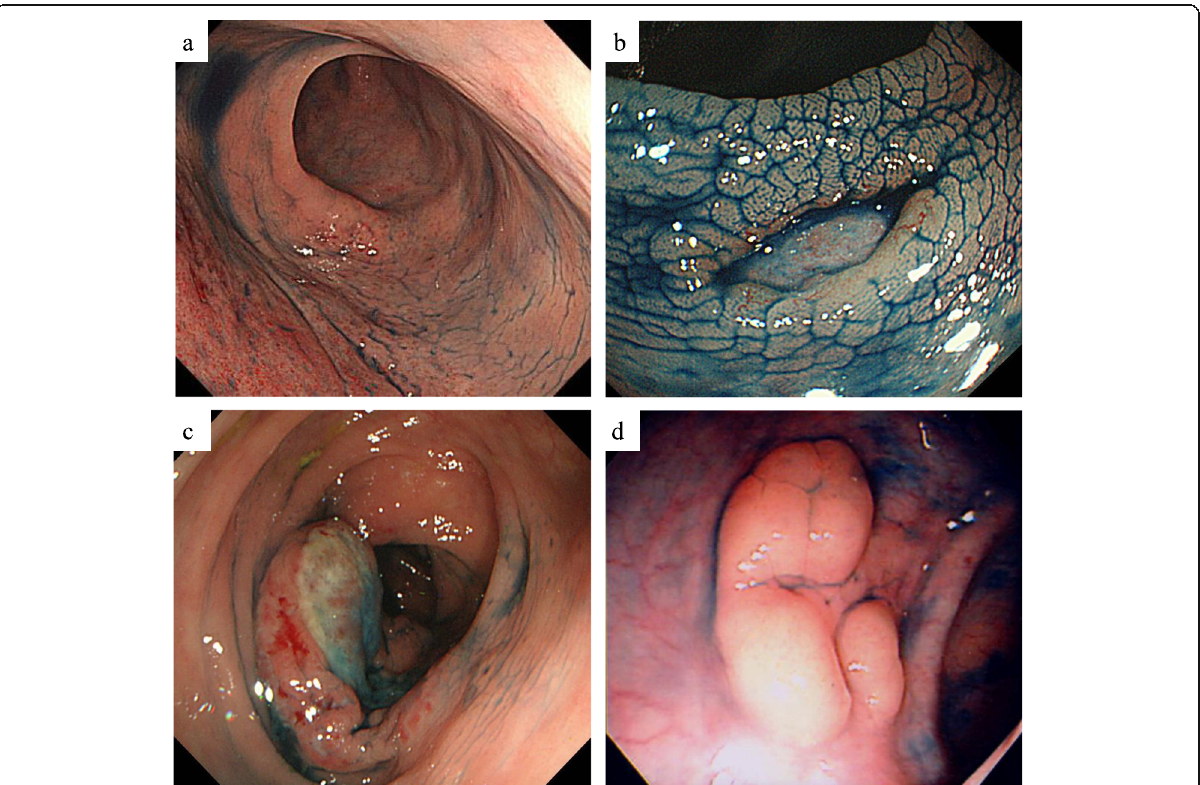
Fig. 1 Endoscopic findings of patients with colorectal TNKCL. Low GI endoscopic views of the colon showing ( a ) diffuse infiltrating type MEITL, ulcerative type ( b ) ATLL and ( c ) EBV+ CD56 negative TNKCL, and ( d ) polypoid type